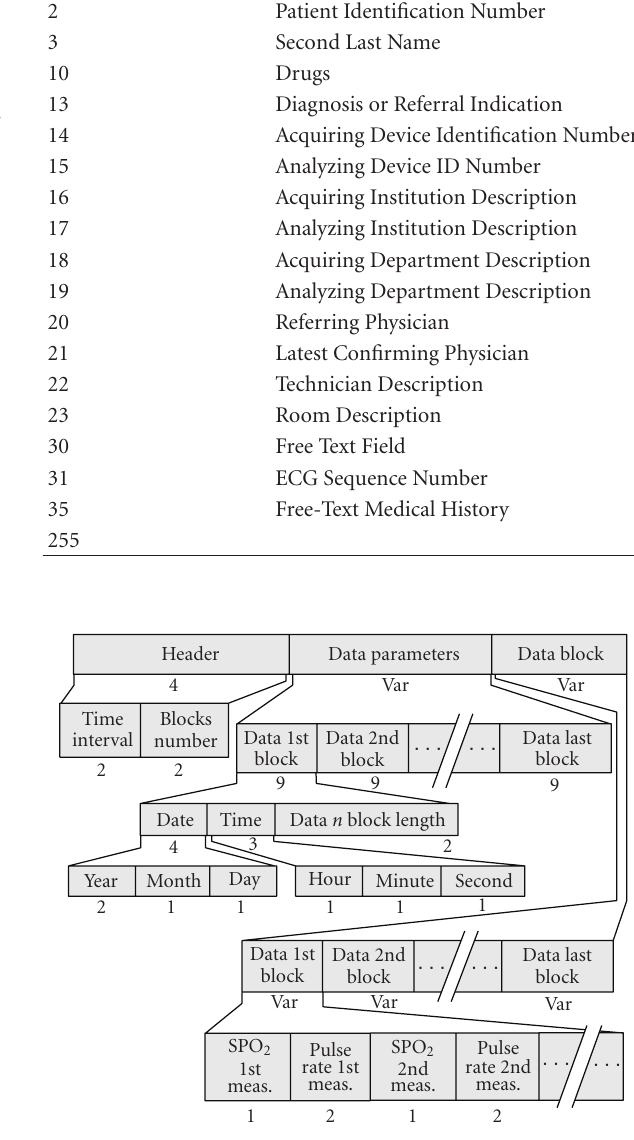
Figure 1: Overview of the data part holding the SPO 2 and pulse rate data